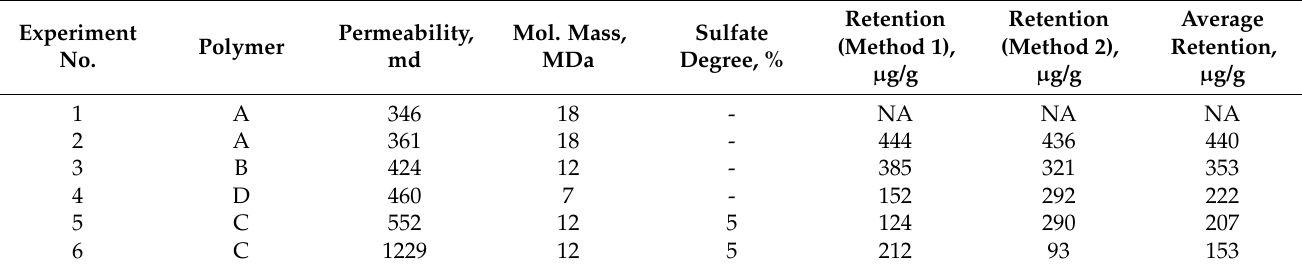
Table 5. Summary results of core